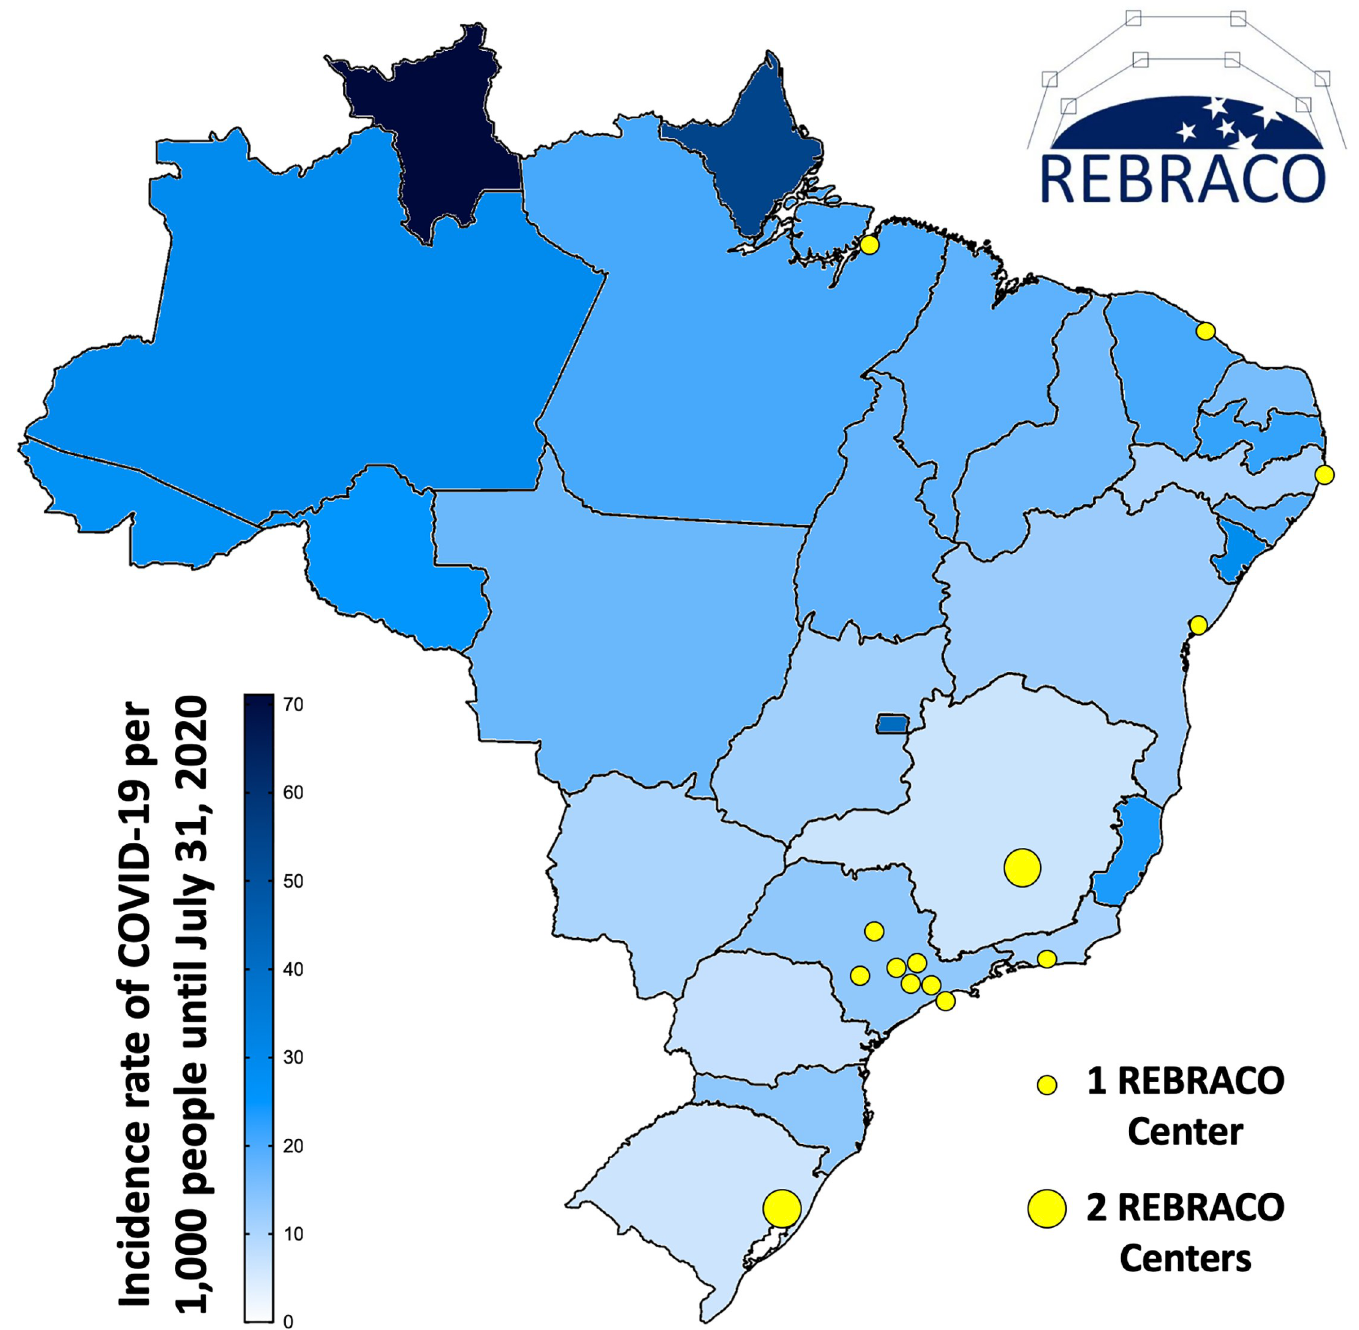
Fig 1. Brazil political-geographic map showing its federative units (states), and the location of the participating centers of REBRACO. States colored according to the incidence rate of confirmed cases of COVID-19 per thousand people until July 31, 2020 [2, 12, 13]. Fig 1 was adapted from a map contained in the Brazilian public domain database–Portal Domı´nio Pu´blico (http://www.dominiopublico.gov.br).